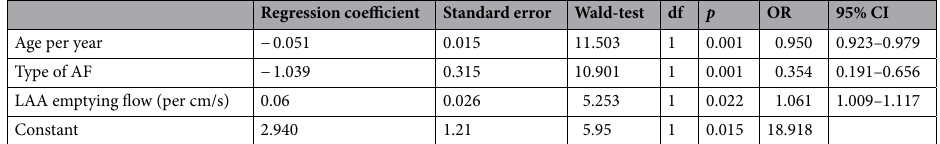
Table 4. Logistic regression analysis of predictors of LAA thrombus